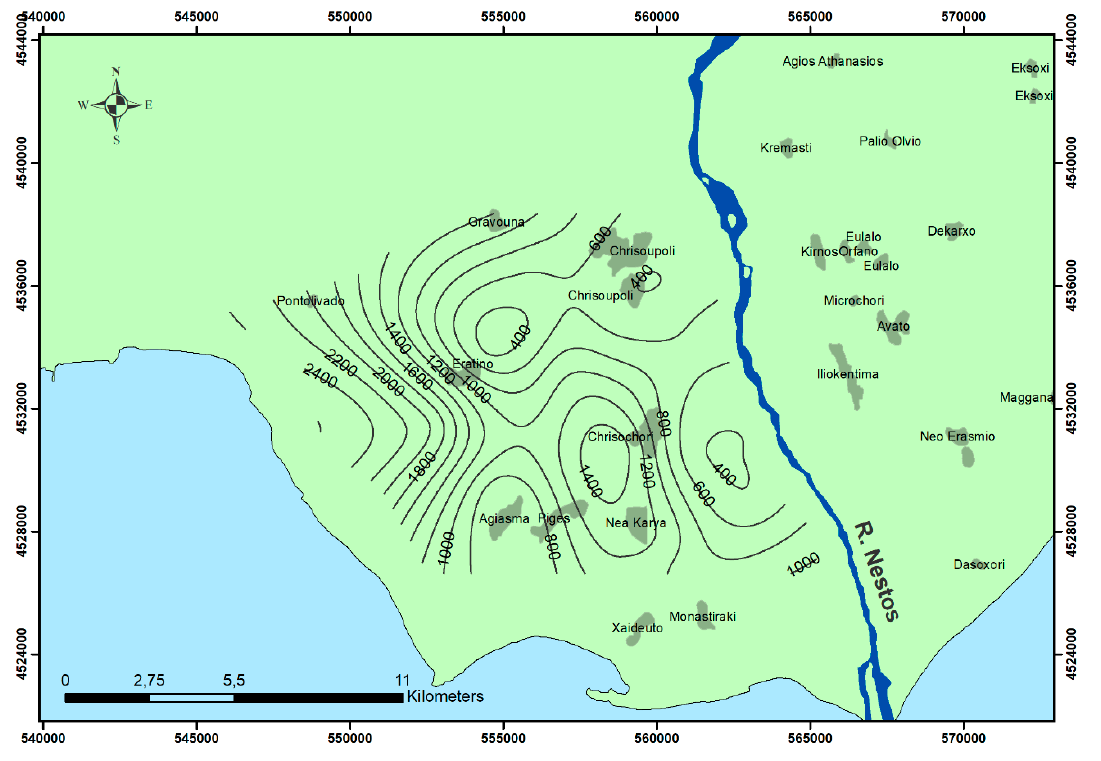
Figure 11. Electrical conductivity distribution map ( μ S/cm) of the confined aquifer (May 2019).